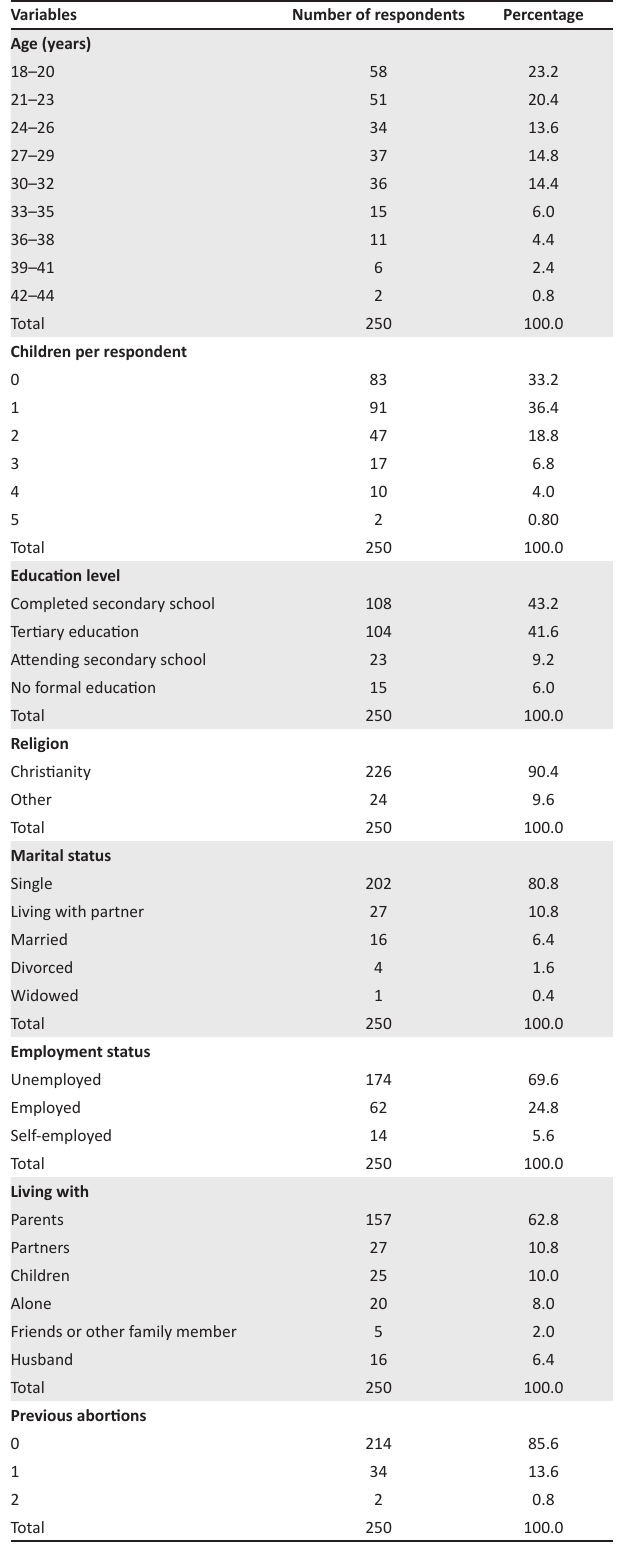
TABLE 1: Demographic characteristics of women seeking termination of pregnancy.